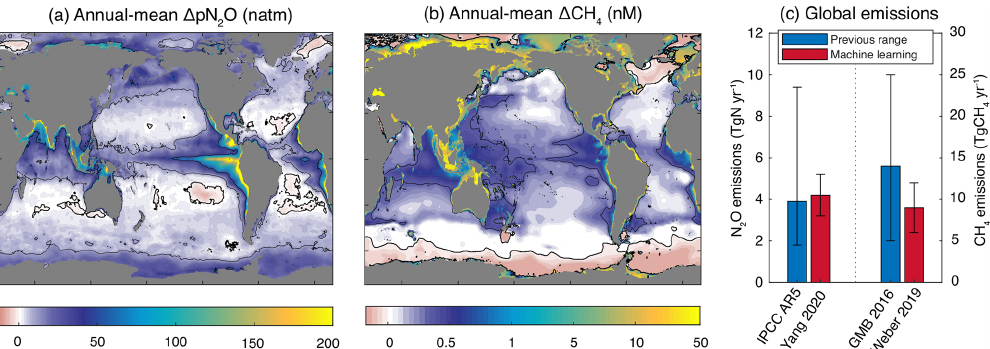
Figure 4. Distributions and emissions of marine CH 4 and N 2 O, (a) air–sea N 2 O disequilibrium mapped using a regression forest model (adapted from Yang et al., 2020) and (b) air–sea CH 4 disequilibrium mapped using an artificial neural network model (adapted from Weber et al., 2019). For consistency with the original publications, the air–sea disequilibrium is shown in different units for N 2 O (partial pressure) and CH 4 (concentration). (c) A summary of global ocean CH 4 and N 2 O emissions estimated by Yang et al. (2020) and Weber et al. (2019), compared to the estimates of the IPCC 5th Annual Report (IPCC AR5) and the Global Methane Budget (Saunois et al., 2016).